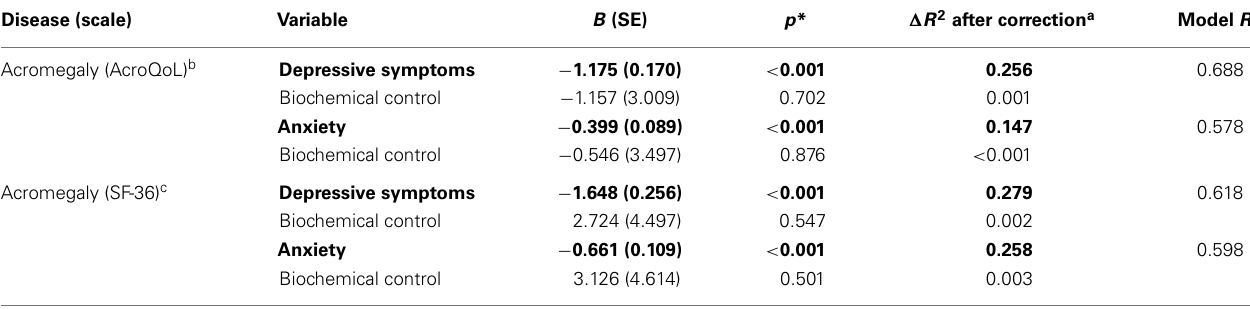
Table 2 |Association of psychopathology/biochemical control and QoL at baseline . Disease (scale)